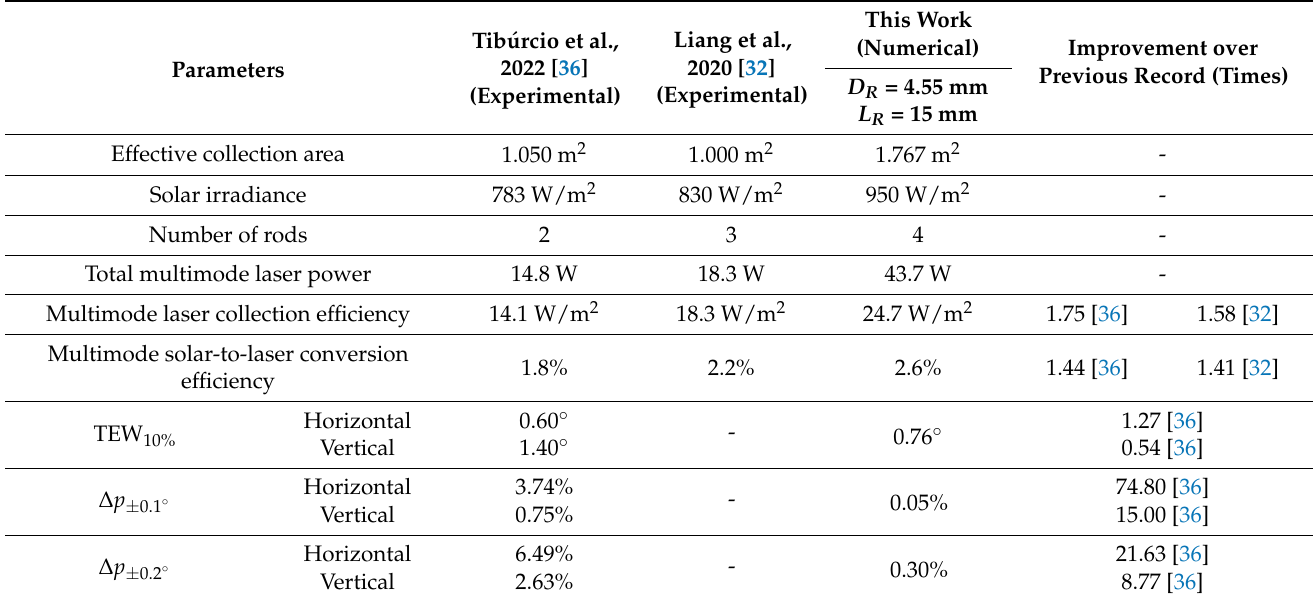
Table 3. Recent experimental progress in multi-rod solar laser performance with the NOVA heliostat- parabolic system and using Nd:YAG laser